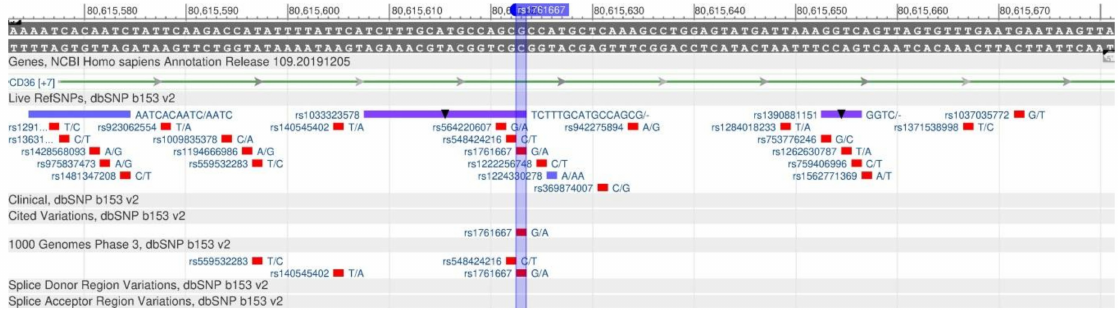
Figure 27. A plot of the CD36 gene (located on the long (q) arm of chromosome 7) containing the oligonucleotide polymorphism rs1761667.